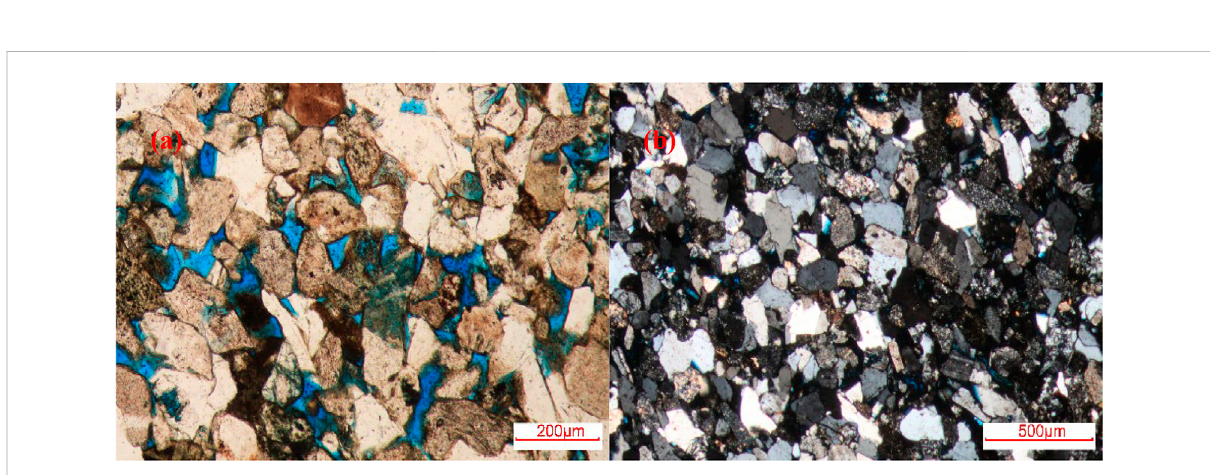
FIGURE 4 CTS of core 11 of Zhoufu 59 – 51 well. (A) The pore system is dominated by intergranular and intragranular solvable pores, single-polarized light image (B) Fine medium-grained feldspar debris sandstone, orthogonal polarization